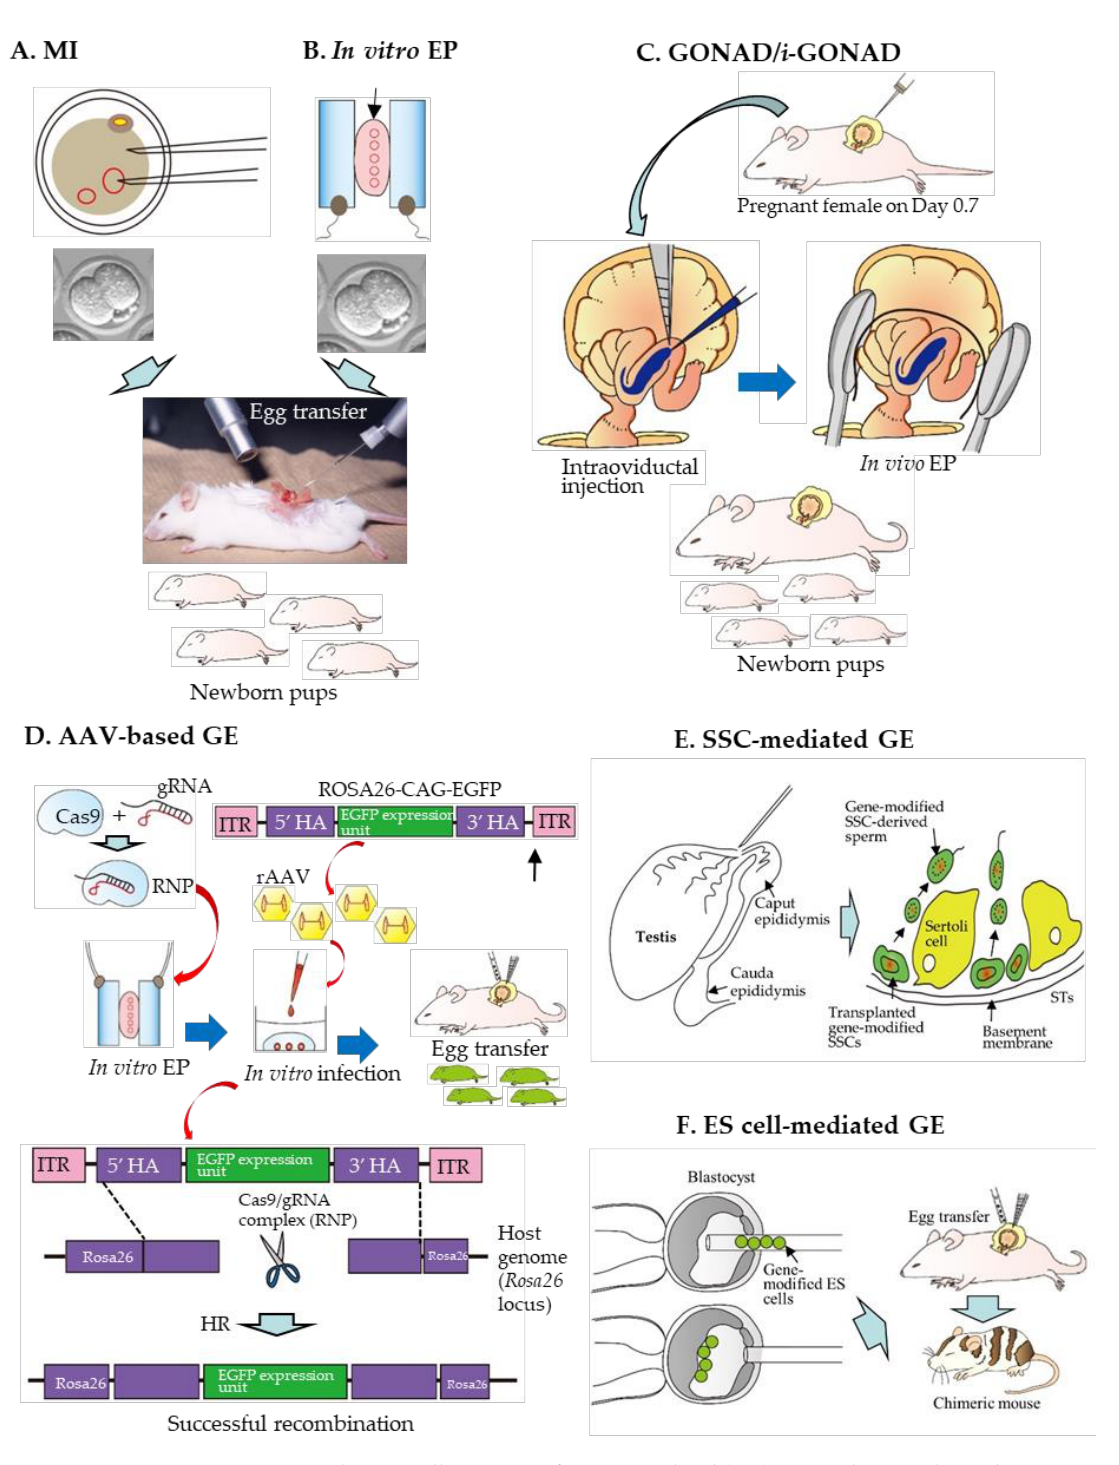
Figure 1. Schematic illustration of genome-edited (GE) rat production through microinjection (MI) ( A ), in vitro electroporation (EP) ( B ), genome-editing via oviductal nucleic acids delivery (GONAD) (or improved genome-editing via oviductal nucleic acids delivery ( i- GONAD)) ( C ), adeno-associated virus (AAV)-based GONAD, a technique enabling in vitro viral infection of zygotes with recombinant AAV (rAAV) ( D ), spermatogonial stem cell (SCC)-mediated transgenesis ( E ), and embryonic stem (ES) cell-mediated transgenesis ( F ). This figure was drawn in-house, based on the data shown in the paper of Sato et al. [158].